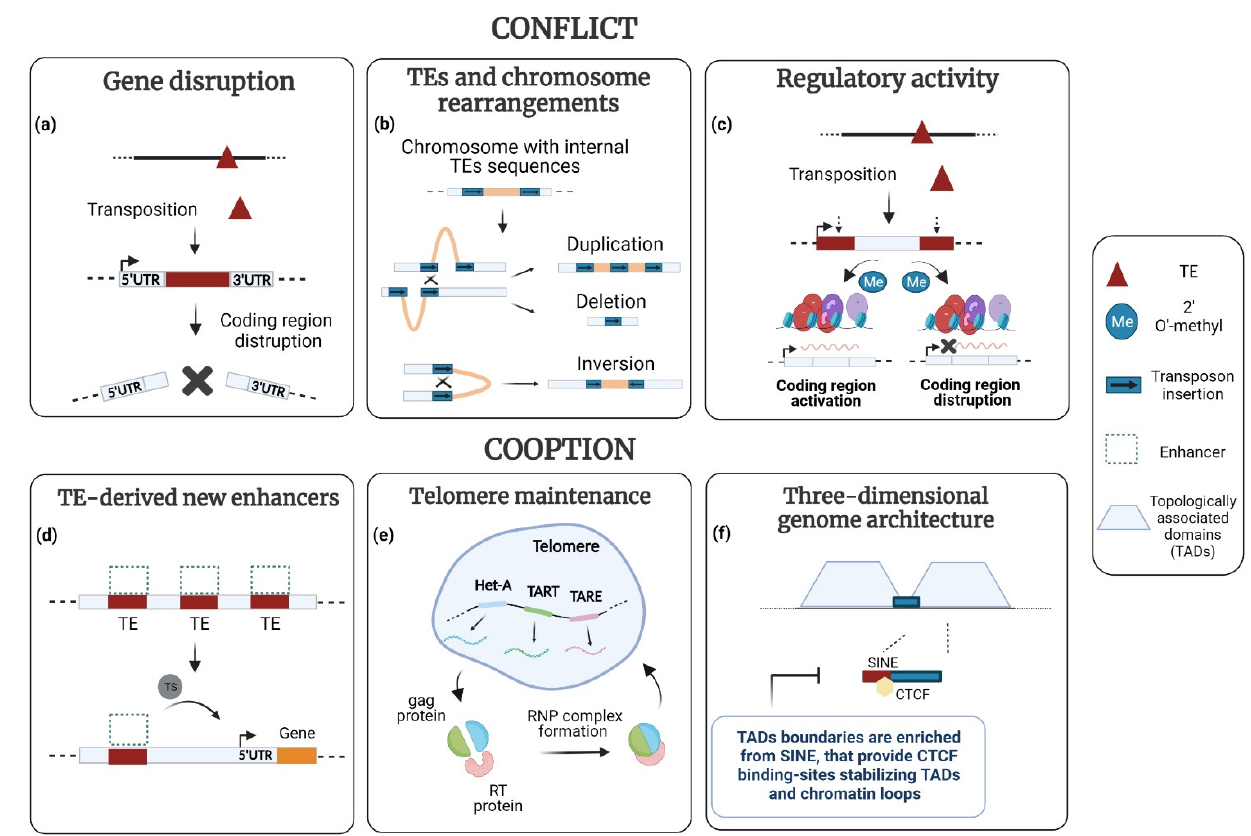
Figure 2. TEs as ‘molecular parasites’ or ‘functional symbionts’. As ‘molecular parasites’ TEs can produce a variety of detrimental effects on the host genome. ( a ) The insertion of TEs within coding exons can cause frame shift mutations disrupting protein sequence and function. ( b ) TEs can cause genomic instability being the substrate for chromosome rearrangements, such as duplications, deletions, inversions and translocations. ( c ) The insertions of TEs in regulatory stretches such as in 5 ′ or 3 ′ regions or introns can cause epigenetic modifications resulting in inappropriate activation or repression of gene expression. The co-option of TEs by the host genome may generate new regulatory signals or coding sequences. This process is referred to as ‘molecular domestication’. ( d ) TEs may contribute new enhancer sequences for transcription factors (grey circle) changing the spatial/temporal regulation of gene expression. ( e ) After the loss of telomerase, retrotransposons can actively participate in the maintenance of telomeres. Three non-LTR families, HeT-A, TAHRE, and TART form a head-to-tail array. They express Gag and Reverse Transcriptase proteins that are necessary for the elongation of telomeres. ( f ) TEs can contribute to the maintenance of genome architecture by providing binding sites for the CTCF protein that is responsible for establishing “topologically associated domains” (TADs). “Created with BioRender tool. https://app.biorender. com/” (accesed on 8 February